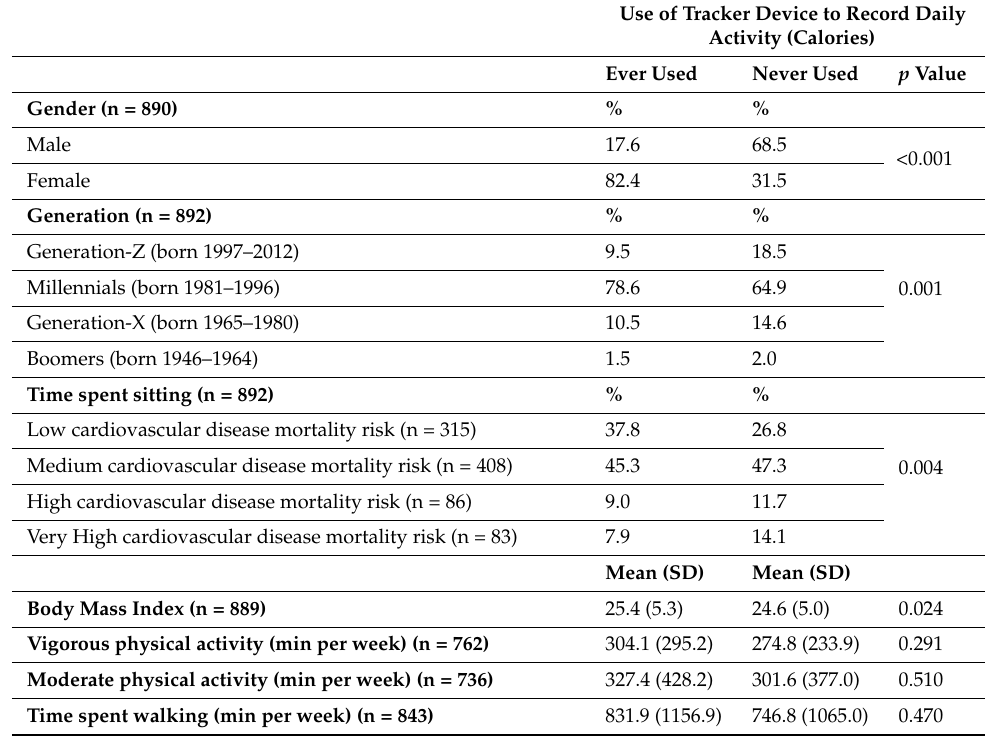
Table 3. Comparative analysis of the characteristics of the sample according to the use of tracker devices to record daily activity (calories).